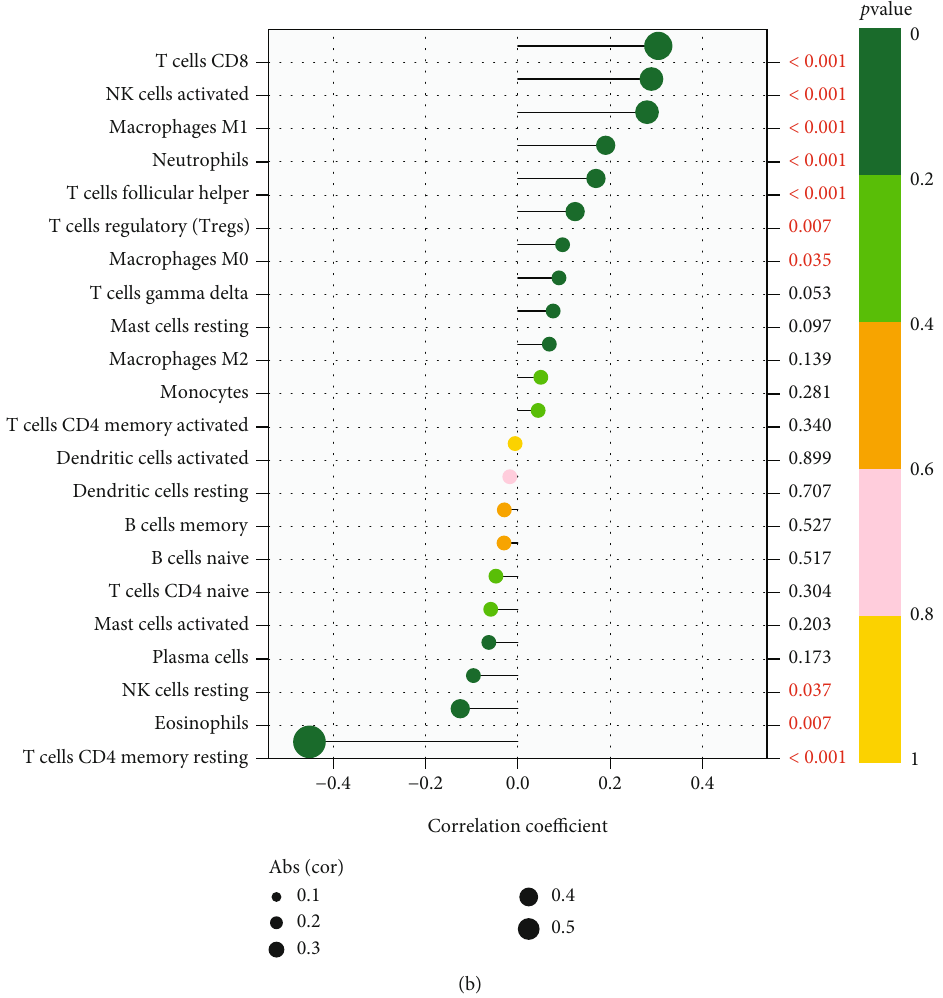
Figure 5: Correlations of LY6E expression with immune in fi ltration level in CRC. (a) The change ratio of immune cell types in the high LY6E- and low LY6E-expression groups in colorectal cancer samples. (b) LY6E expression was positively correlated with the in fi ltration level of CD8+ T cells and negatively correlated with CD4 memory resting T